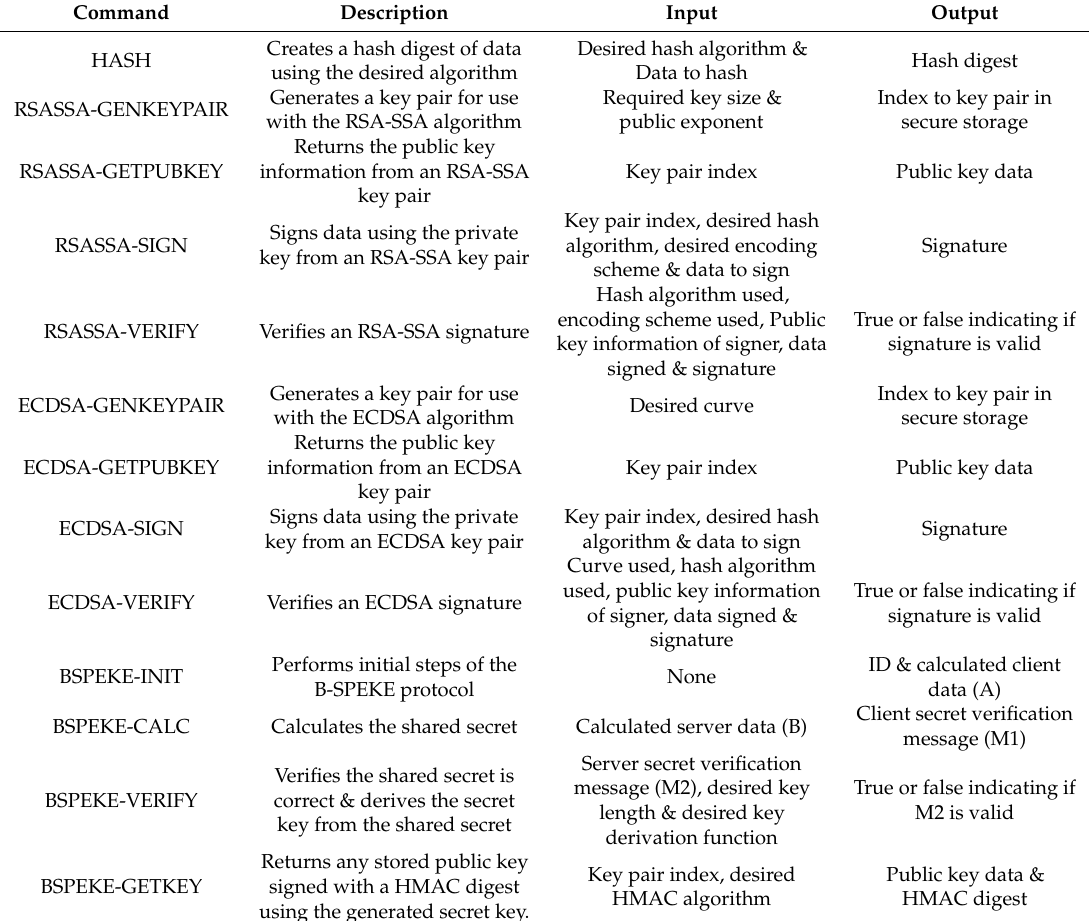
Table 8. Overview of available commands in the security